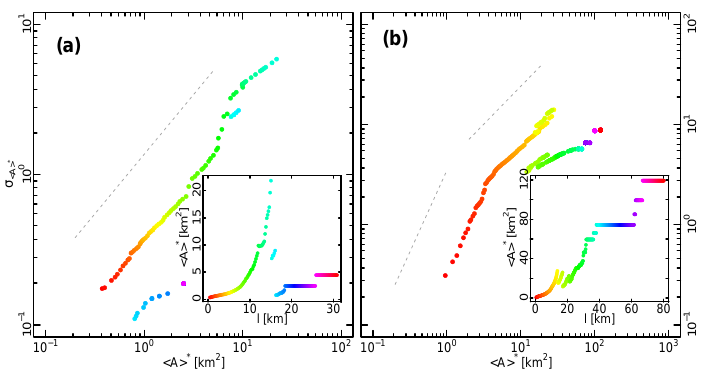
Figure 6. Taylor’s law for city sizes. The standard deviation σ ∗ of cluster sizes disregarding the largest A cluster is plotted as a function of (cid:104) A (cid:105) ∗ for various values of l . The panels show the results for ( a ) Austria and ( b ) Spain. The insets depict the corresponding curve of (cid:104) A (cid:105) ∗ against l (see also Figure 4a). In the panels and insets corresponding coloring is used in order to enable comparison. For Austria, the standard deviation σ ∗ reaches its maximum at l = 15km (light-blue) and for Spain it is located at A l = 13.6km (yellow). In the former case this maximum corresponds to the percolation point. In the latter case the maximum corresponds to the first peak one can identify in the curve of (cid:104) A (cid:105) ∗ against l